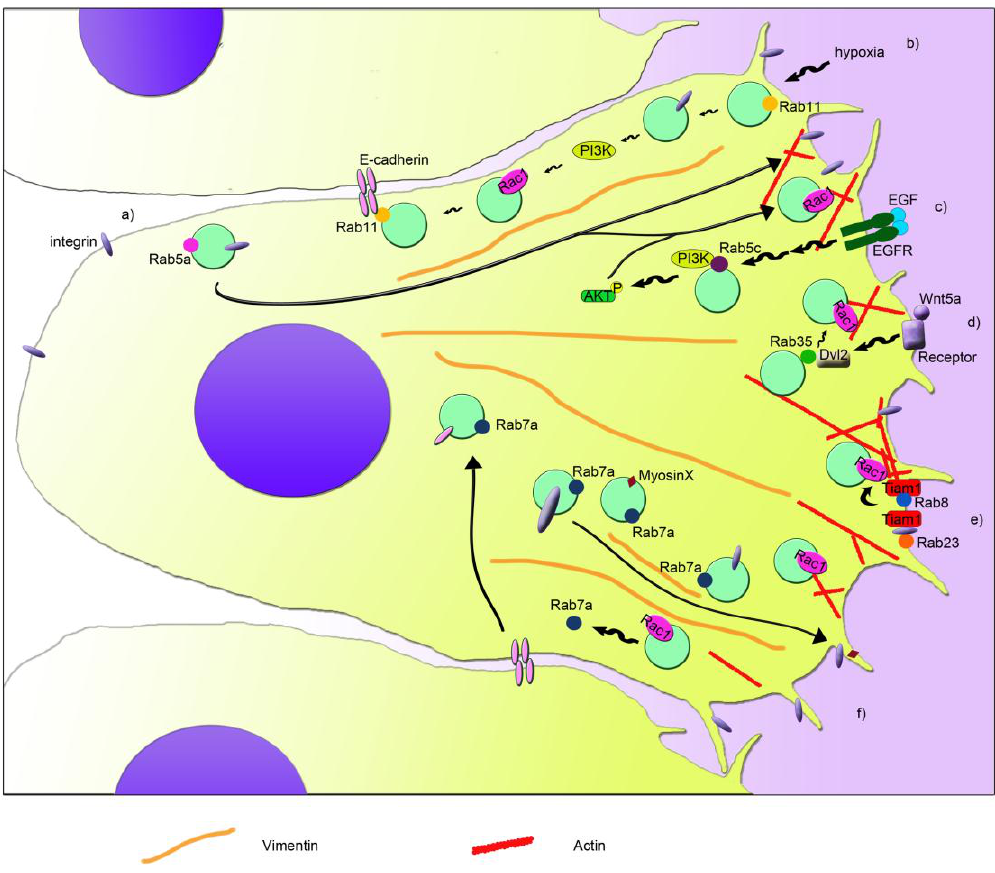
Figure 1. Schematic model that depicts the coordination of Rab proteins and Rac1 in cell migration. Different pathways are indicated with letters. ( a ) Rab5a regulates the internalization and recycling of integrins from the rear edge to the leading edge. This regulation is important for the formation of new adhesions at the front of the cell, for Rac1 activation, and for actin filament (in red) reorganization. ( b ) Rab11 interacts with E-cadherin and recruits and activates Rac1 at the plasma membrane. In hypoxia, αvβ3 integrin and PI3K are activated through the action of Rab11, leading to Rac1 activation and cell migration. ( c ) Cell stimulation with EGF and its binding to EGFR modulates activity of PI3K and AKT in a Rab5c-mediated manner. This in turn leads to increased Rac1 activity, membrane ruffles, and cell migration. ( d ) Wnt5a signaling induces the activation of Dvl2, which binds to Rab35 activating it. Active Rab35 increases Rac1 activity and therefore cell migration. ( e ) Rab8 activation induces Rac1 activation mediated by a Rac1 GEF called Tiam1, regulating cortical actin polymerization and focal adhesion reorganization. Furthermore, active Rab23 interacts with Tiam1, through its interaction with β1 integrin, regulating Rac1 activity and cell migration. ( f ) Rab7a regulates cell migration by modulating Rac1 activity, β1 integrin, and myosin X transport at the leading edge and the regulation of vimentin filament organization (in orange). Moreover, Rac1 regulates Rab7a activity and in turn E-cadherin degradation in lysosomes, and therefore cell-cell contacts.